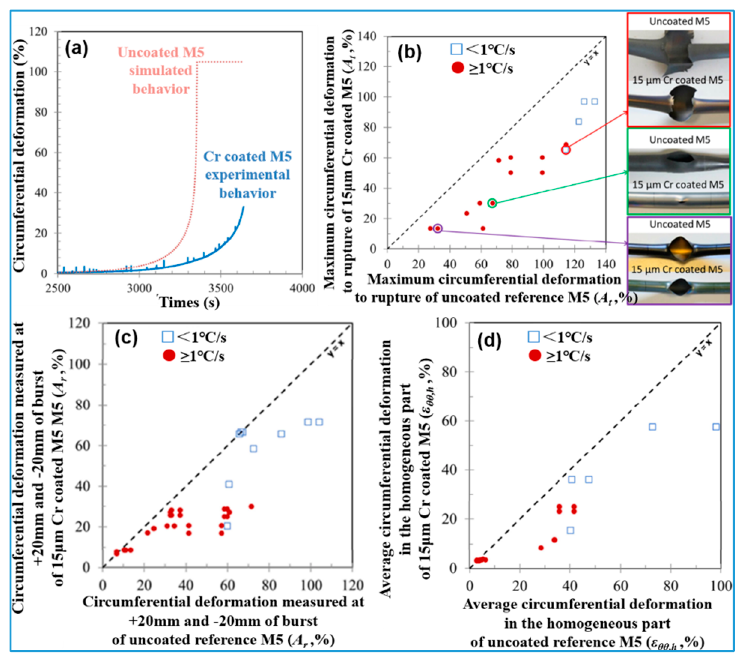
Figure 12. Results of the thermal ramp test on Cr-coated zirconium alloy cladding: ( a ) circumferential deformation of Cr-coated (experimental) and uncoated (simulated) M5 tubes as a founction of time; comparisons in the measured circumferential deformations — A t ( b ), A r ( c ) and ε θθ , h ( d ), respectively — between Cr-coated and uncoated (both experimental) M5 tubes tested for different heating rates. Reproduced from the work in [67] with copyright permission from the American Nuclear Society (ANS) and the author.